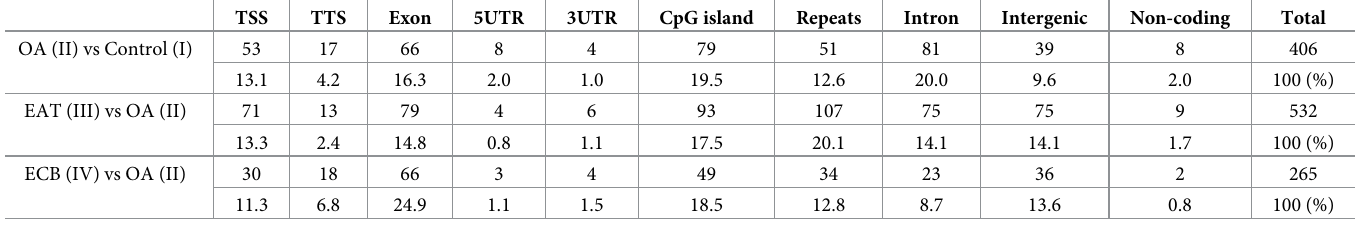
Table 3. Distribution of selected significant DMRs among genomic